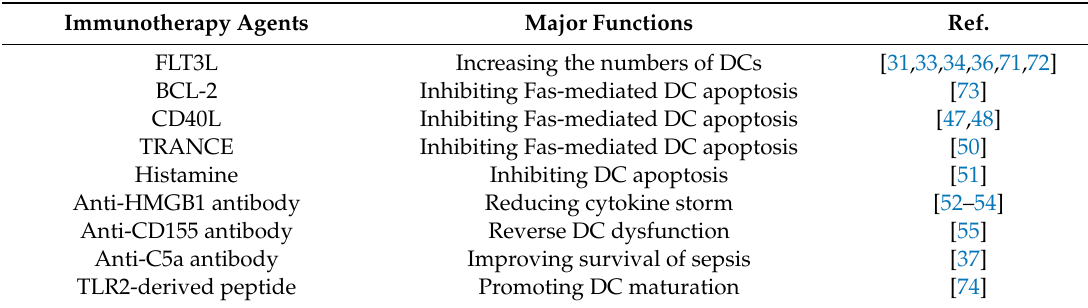
Table 1. Immunization of sepsis with DCs as the